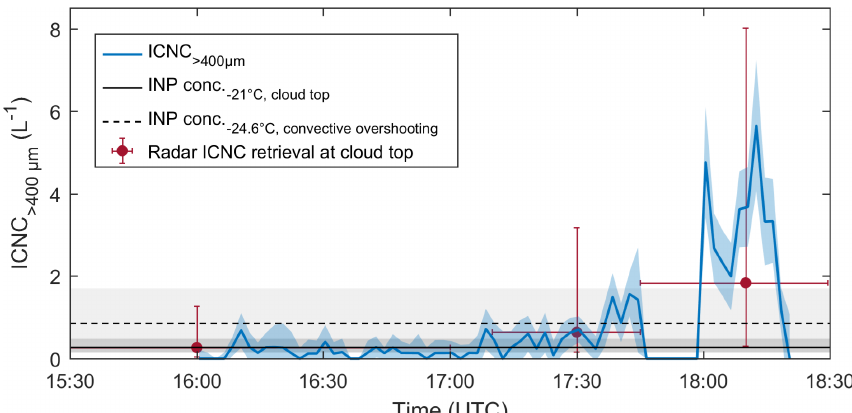
Figure 11. Time series of the ICNC > 400µm (blue line) measured near cloud base by the HoloBalloon platform. Ice particles larger than 400µm in diameter were assumed to have formed near cloud top. The blue shaded area indicates the uncertainty of the ICNC. No mea- surements were available between 17:50 and 18:00UTC. The estimated INP concentrations extrapolated to − 21 ◦ C (cloud top, solid line) and to − 24 . 6 ◦ C (convective overshooting, dashed line) are indicated by the black horizontal lines. The gray shaded areas show the upper and lower bounds of the estimated cloud top INP concentration (dark gray) and of the estimated INP concentration at − 24 . 6 ◦ C (light gray) (estimated from the 95% confidence interval of the fit in Fig. 10). The cloud top ICNCs retrieved from the radar observations (Sect. 2.3.1) are shown by the red dots. The reported ICNCs represent an average over the top 10 range gates (300m from cloud top) for three different time periods (14:30–17:00UTC, 17:10–17:45UTC, 17:45–18:30UTC). The vertical red lines indicate the error in the retrieved ICNC, whereas the horizontal red lines mark the extent of the time